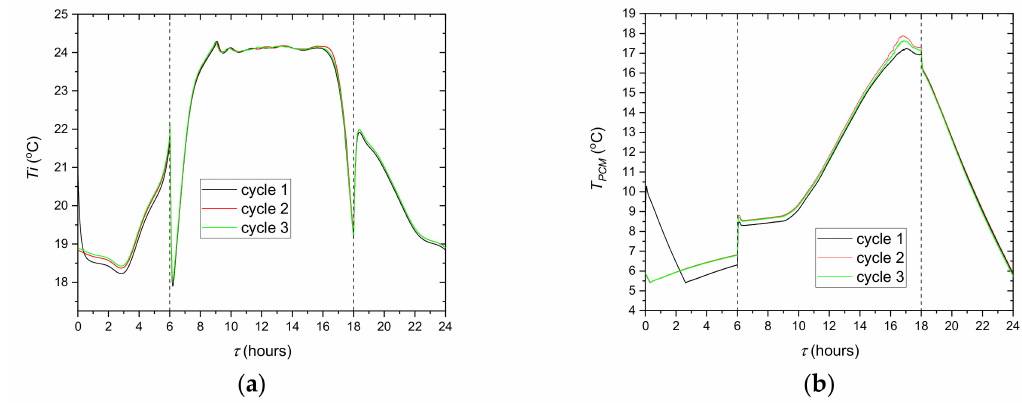
Figure 19. Evolution of the calculated indoor temperature of the office T i ( a ) and the measured PCM average temperature T PCM ( b ) in three